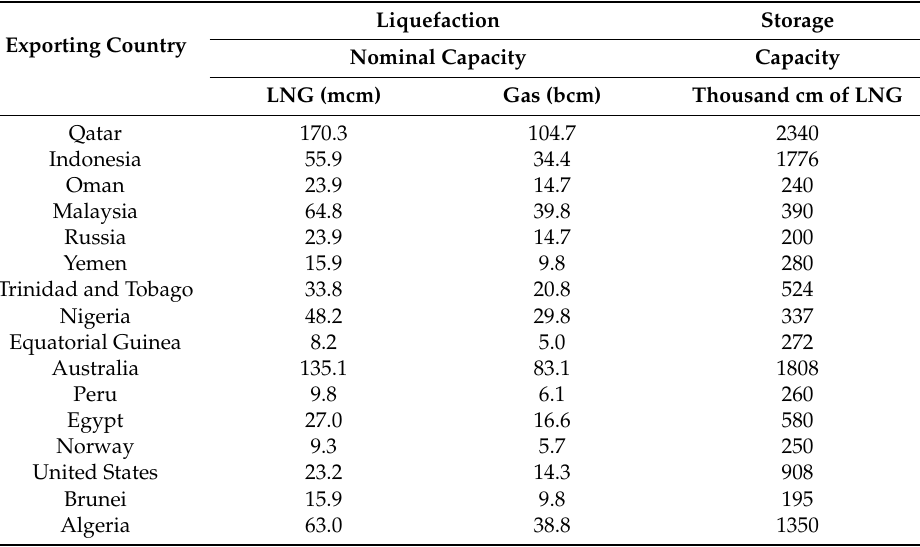
Table 2. Liquefaction and LNG storage capacity of exporting countries.